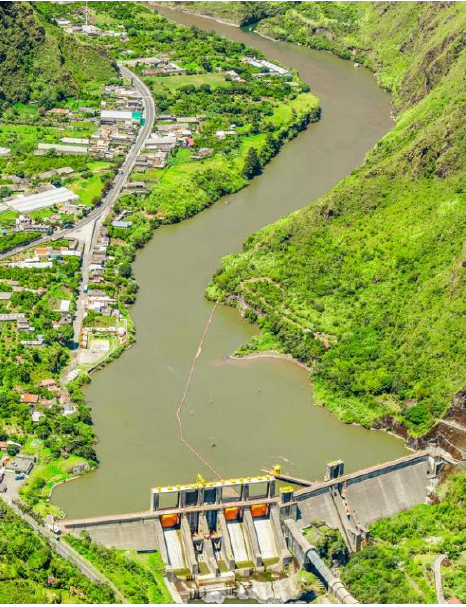
Figure 2. The reservoir of the Hidroagoyán Dam. The dam is visible on the bottom part of the image (courtesy CELEC E.P.).